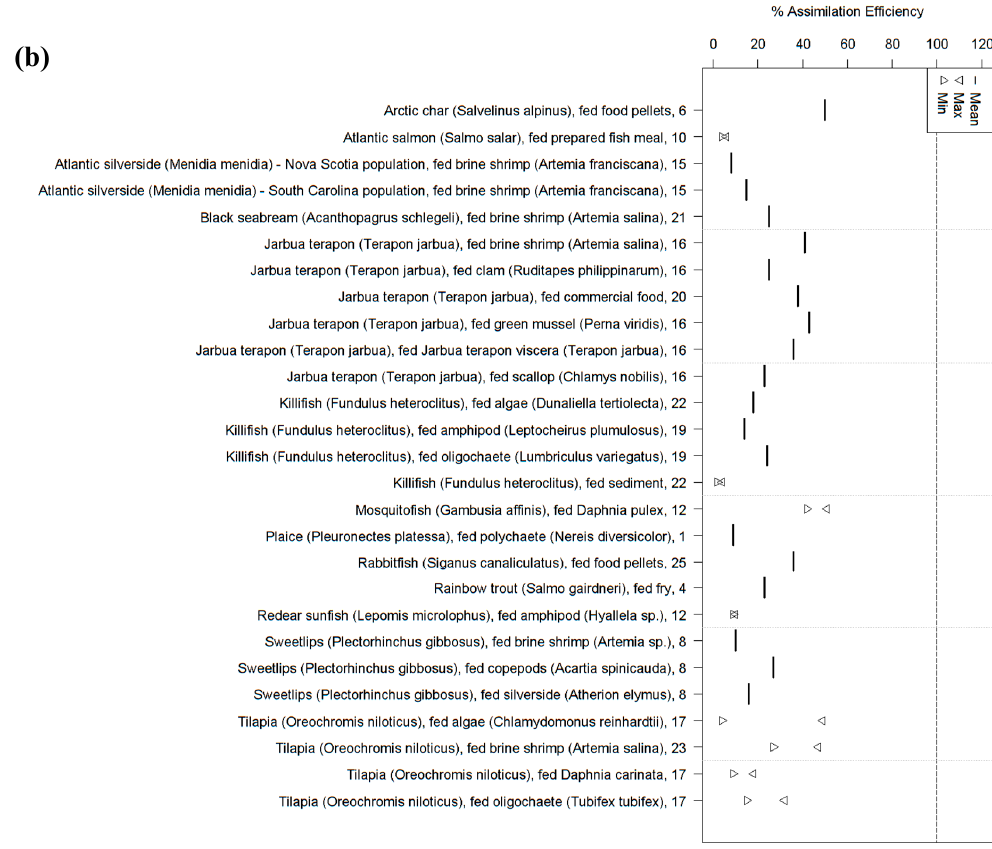
Figure 2. Summary of studies on AE of Hg into fish for ( a ) MeHg and ( b ) Hg(II). In both, each column represents a single species of fish, fed a single type of food. The numbers along the Y-axis indicate studies, as outlined in Table S2.